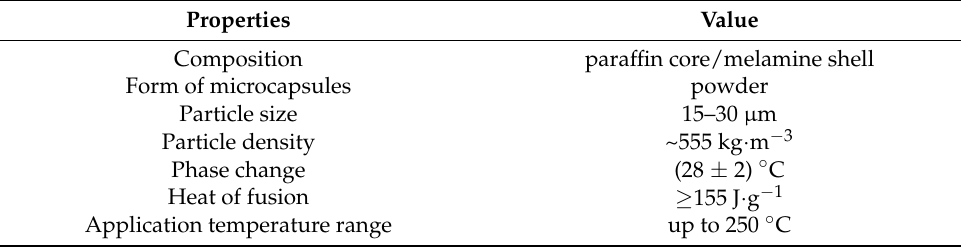
Table 2. Characteristics of PCM microcapsules